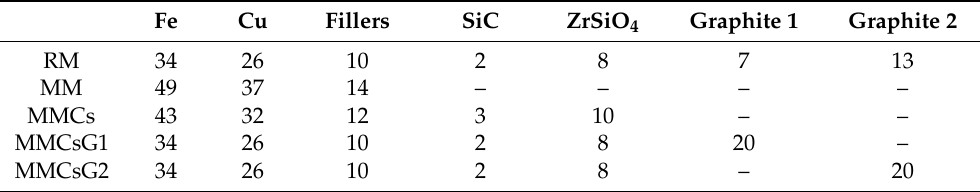
Table 1. Summary of the formulation (in wt%) of all materials used in this work.